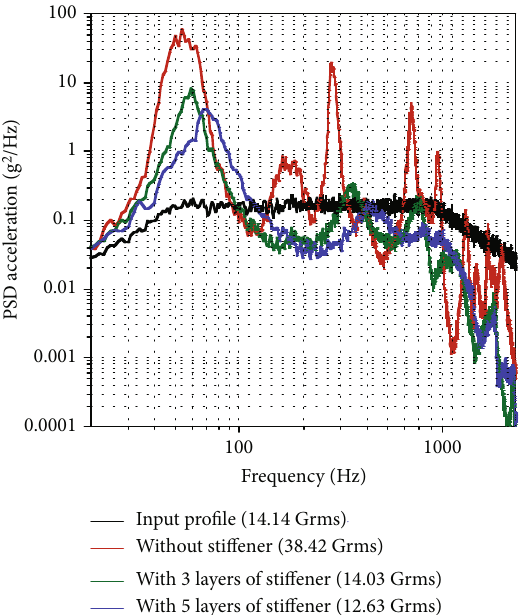
Figure 10: Sinusoidal vibration test results of the solar panels in the z -axis excitation.